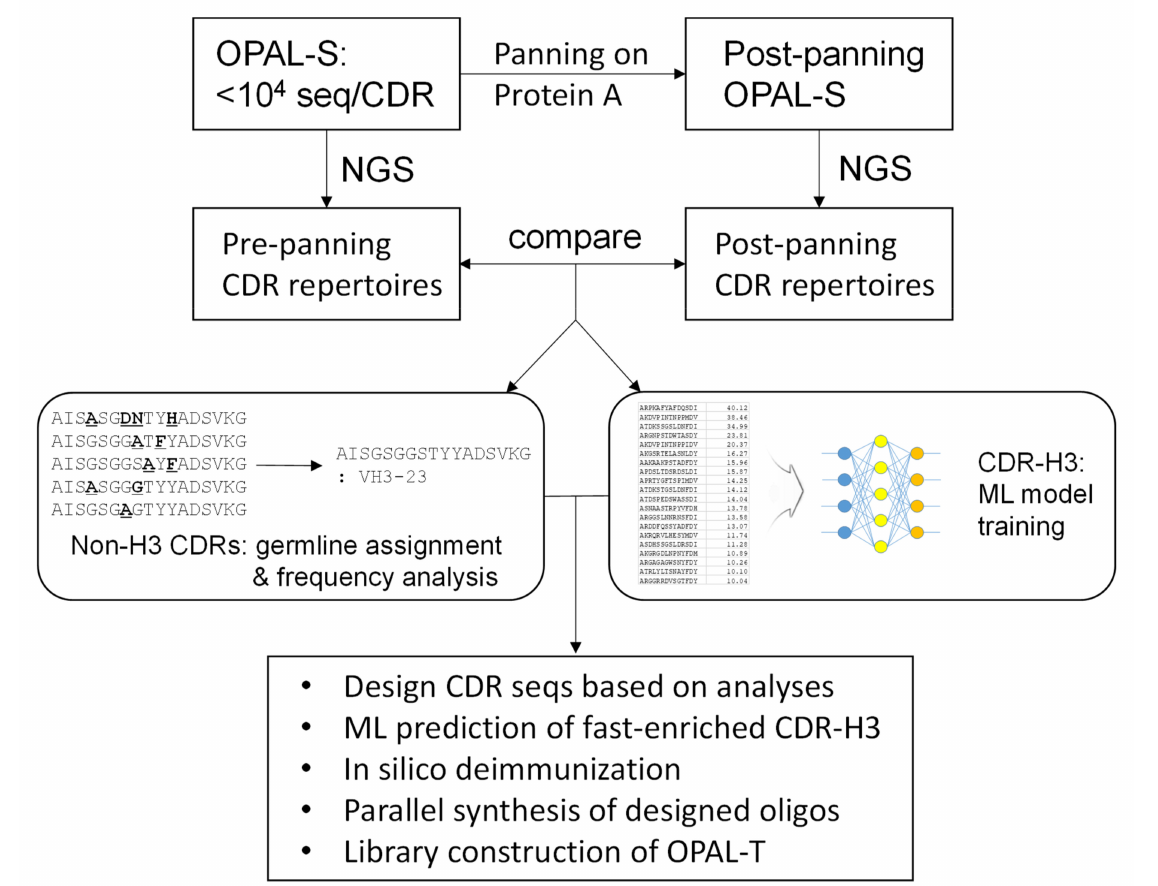
Figure 1. Library design process for OPAL-T. Non-combinatorial CDR repertoires of the previous generation scFv library OPAL-S before and after panning against protein A were analyzed by NGS. The enrichment pattern of CDR sequences was applied to the design of OPAL-T. For CDR-H3 especially, ML models were trained on the NGS data and utilized for the design of improved CDR-H3